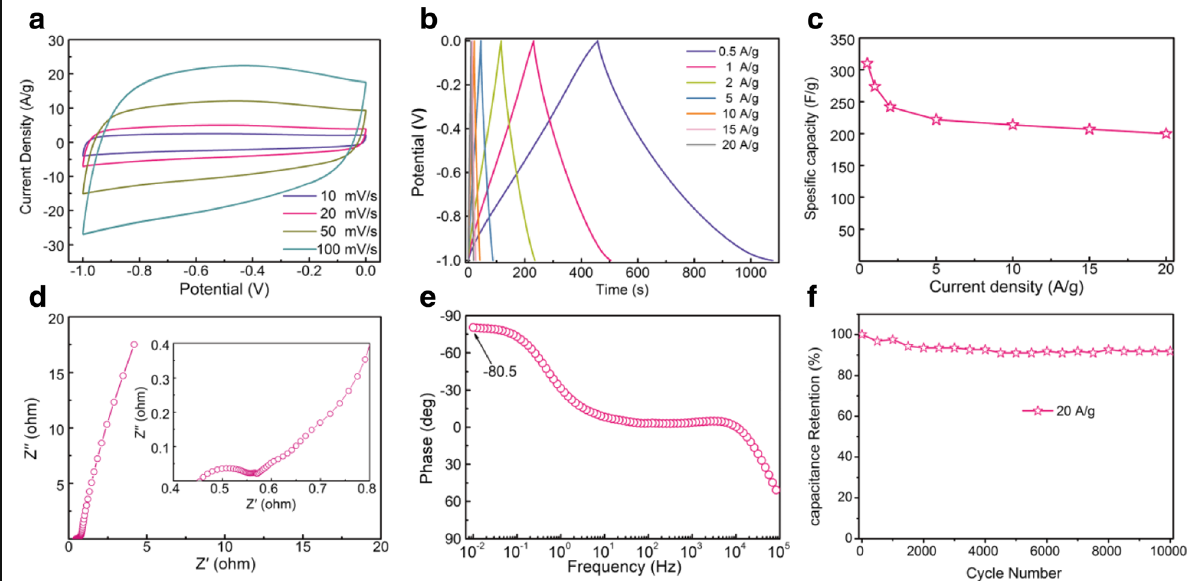
Fig. 3 The electrochemical characteristics of the aMCSs-0.4 electrode. a CV curves at different scan rates from 10 to 100 mV s − 1 . b GCD curves at different current densities from 0.5 to 20 A g − 1 . c Specific capacitance as a function of current densities. d Nyquist plot and the inset show the magnify plots at a high-frequency range. e Bode plot. f Cycling performance at a current density of 20 A g − 1 for 10,000